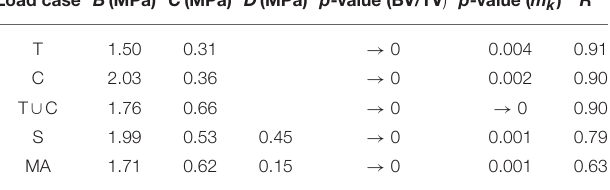
TABLE 3 | Results from the multi-linear regressions between k [ E 0 − E dam ] k at 0.5% strain level, BV/TV, fabric eigenvalues, and macroscopic strain Frobenius norms, in log-log